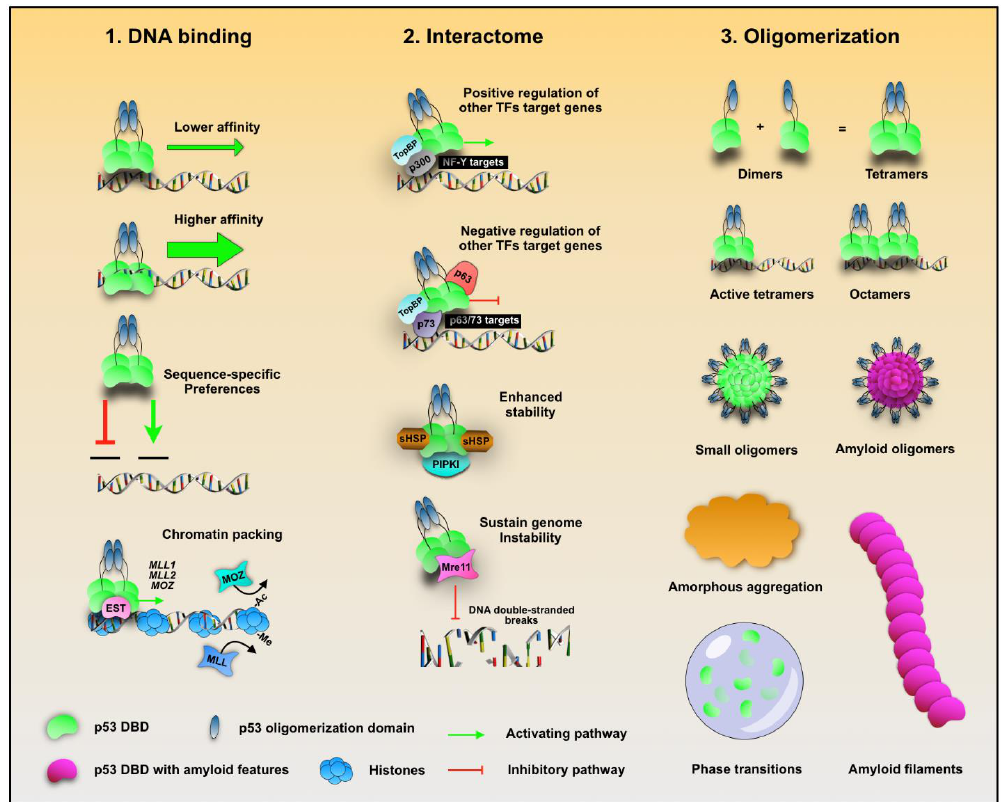
Figure 2. The spectrum of outcomes arising from p53 mutations. Cancer-related mutations affect p53 in multiple ways such as its properties and preferences to bind DNA, its cellular partners, and the propensity to associate itself forming a broad range of oligomeric species and phase transitions. TFs, transcription factor.